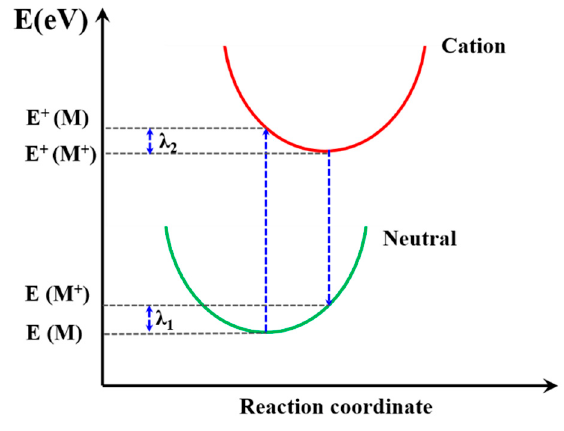
Figure 8. Schematic plot of reorganization energy. Table 3. Calculations of vertical ionization potentials (IP), electron affinities (EA), and reorganization energy ( λ ).